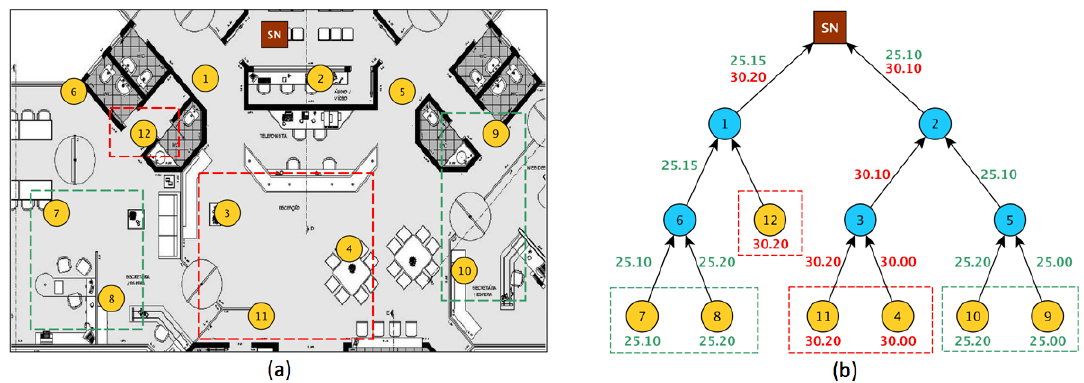
Figure 3. ( a ) Eleven sensor nodes deployed over a laboratory. ( b ) The 11 sensors build a routing tree. Notice correlated sensors nodes that are not close to each